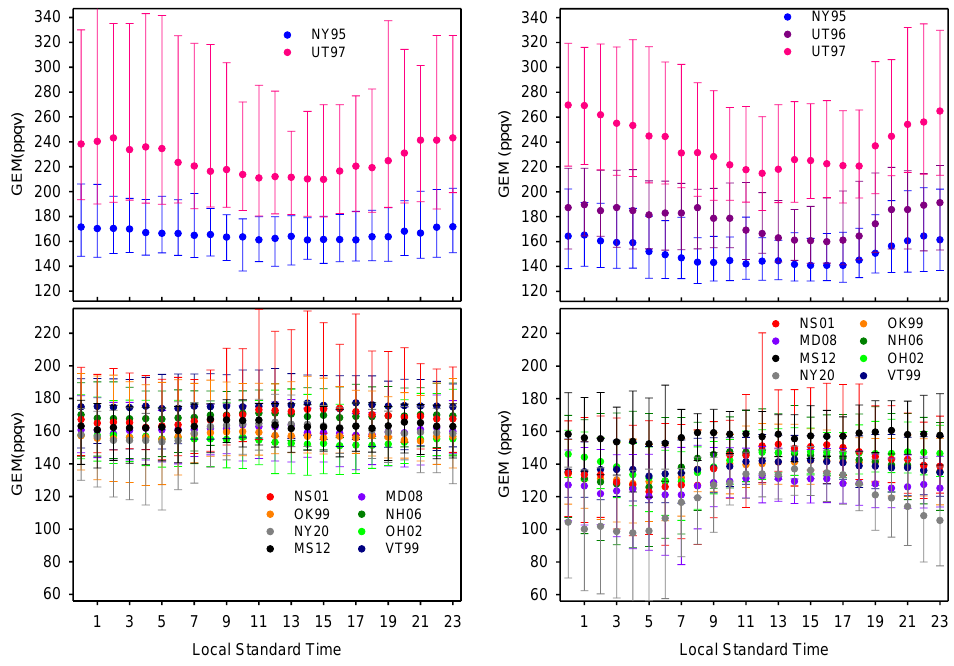
Fig. 6. GEM diurnal variation in 2009 spring (left panel) and 2009 summer (right panel). The upper error bars represent 90 percentile while the lower error bars represent 10 percentile values.